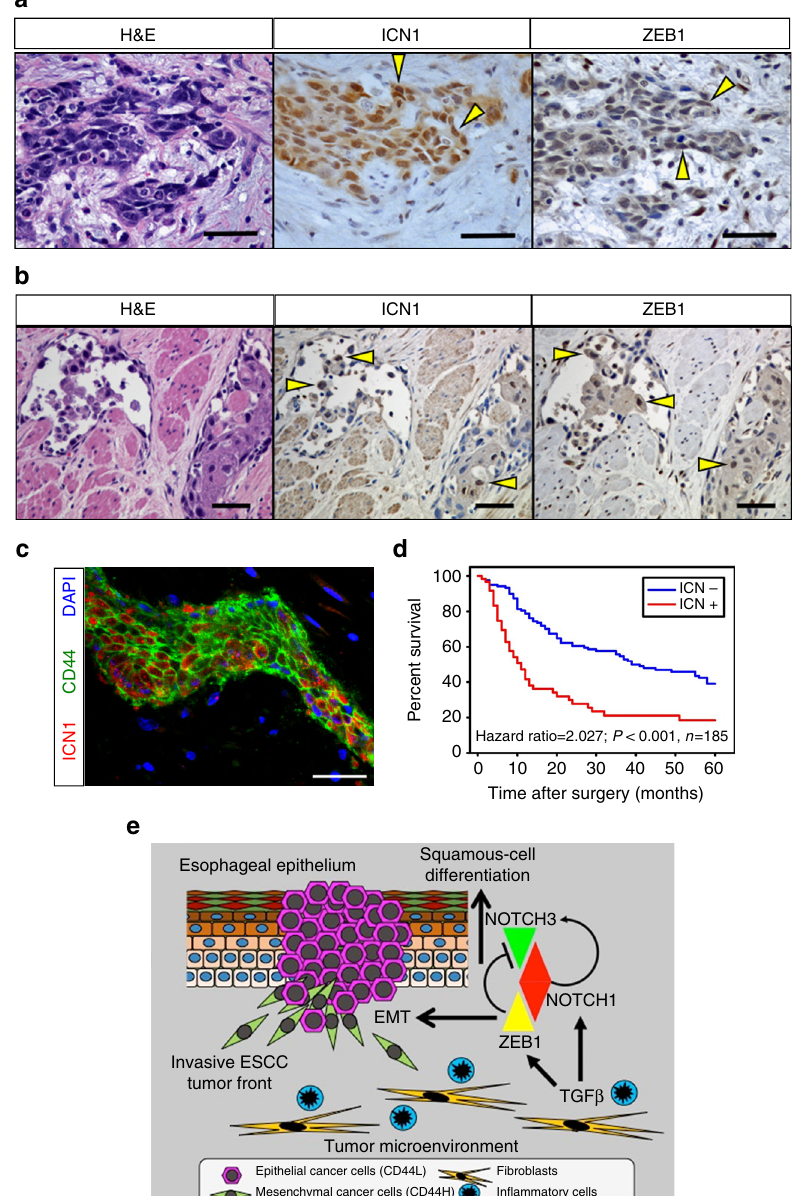
Fig. 7 NOTCH1 activation and ZEB1 expression in invasive ESCC predicts poor prognosis. a , b Representative IHC images for ICN1 and ZEB1 in ESCC cells in a deep invasive tumor nest and ESCC cells invading into lymphatic vessels. a ESCC #55; b ESCC #62 in Supplementary Data 1. c Representative IF image for ICN1 and CD44 in invasive ESCC cells. Scale bars, 50 μ m in a – c . d Survival curve for 185 post-surgical ESCC patients with or without ICN1 expression at the tumor invasive front. e Model of the role of Notch1 in EMT in ESCC. Notch1 activation promotes tumorigenicity and heterogeneity in SCC via EMT. Notch1 drives squamous-cell differentiation by inducing Notch3 in normal squamous epithelia as well as SCC cells. Notch3 limits EMT. In response to TGF β from the tumor microenvironment (e.g., cancer-associated fi broblasts and in fl ammatory cells), however, transcriptional repression of Notch3 by ZEB1 permits Notch1-mediated induction of CD44H cells via EMT. Notch activation may result in the generation and maintenance of CD44H cells possessing mesenchymal properties and enhanced malignant potential. EMT allows neoplastic cells to cope with stress during carcinogenesis and disease progression (e.g., genotoxic stress induced by 4NQO). CD44H cells produce pro-tumorigenic cytokines (e.g., IL-6) and tissue remodeling factors (e.g., MMP13, LOX, and POSTN) (Supplementary Fig. ZEB2 expression upon N3Int2 -modulated transcriptional activ- stimulation (Fig. 6f). TGF β did not prevent ICN1 from binding ity. ZEB1 speci fi cally suppressed basal pGL3-N3Int2-luc reporter activity and also abrogated reporter activation via DOX-induced ectopic ICN1 (Fig. 6e; Supplementary Fig. 4d). Chromatin immunoprecipitation (ChIP) analysis revealed enrichment of ZEB1 binding to the N3Int2 region in puri fi ed CD44L cells with TGF β stimulation and puri fi ed CD44H cells without TGF β